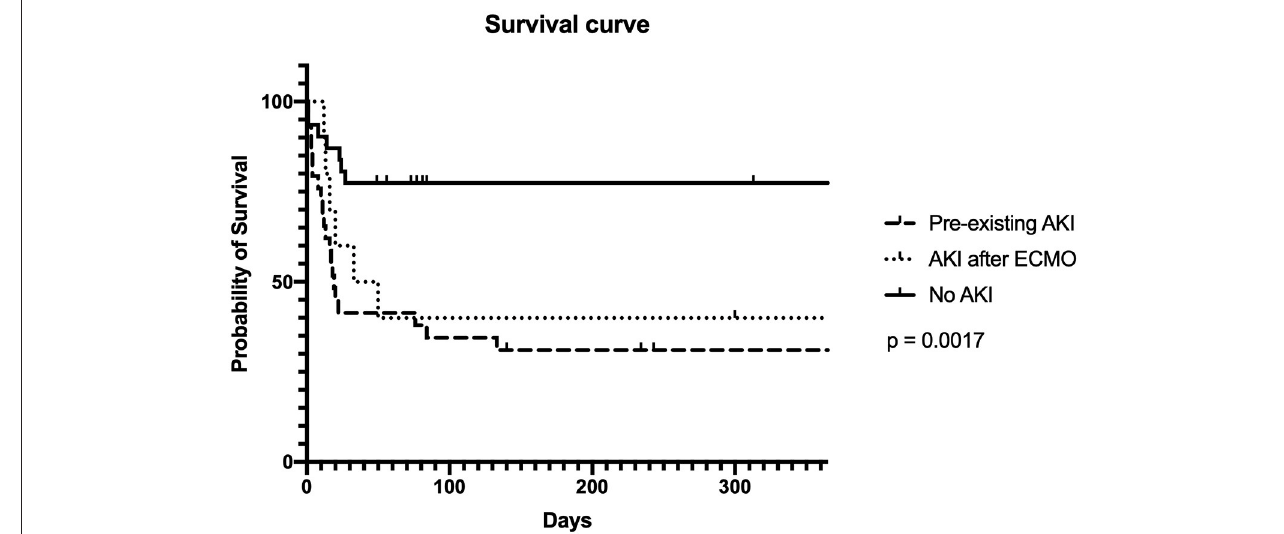
FIGURE 2 | Survival